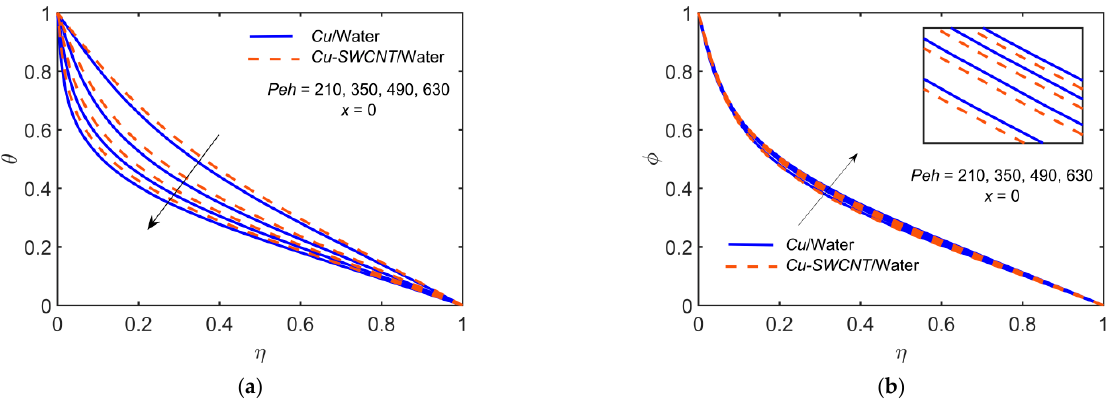
Figure 11. ( a ) The 𝜃 profile and ( b ) 𝜑 profile at 𝑥 = 0 for distinct values of 𝑃𝑒ℎ . Figure 12 depicts the impact of Cu-based NF and Cu-SWCNT-based HNF for the mass diffusion parameter 𝑃𝑒𝑚 = 220, 420, 620 on (a) the concentration (𝜑) profile at 𝑥 = 0 and (b) the concentration (𝜑) profile at 𝑥 = 2 . The figure shows that as 𝑃𝑒𝑚 esti- mations intensify, the concentration profile reduces. The HNF concentration profile is slightly lower than that of the NF.